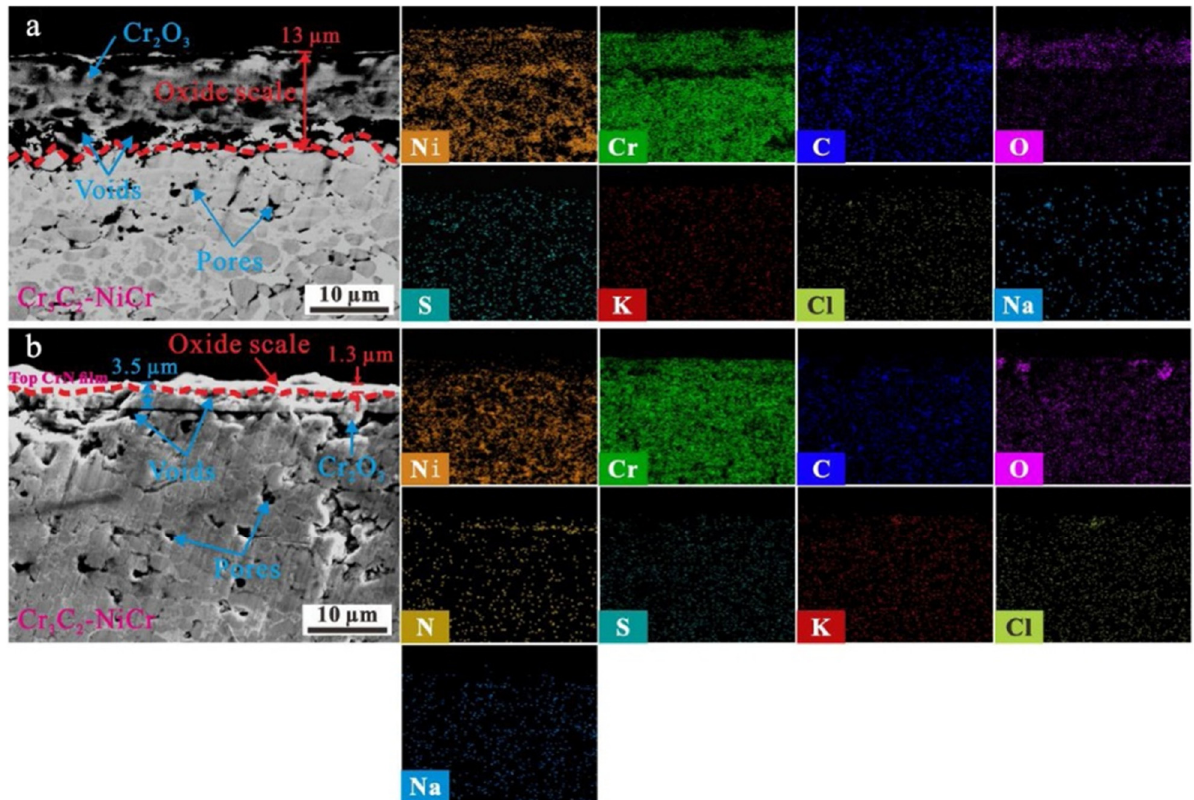
Figure 13. Cross-sectional micrographs and elemental distribution of ( a ) the HVOF coating and ( b ) the HVOF-PVD duplex coating after hot corrosion. Reprinted with permission from Ref. [45]. Copyright Elsevier, 2020.